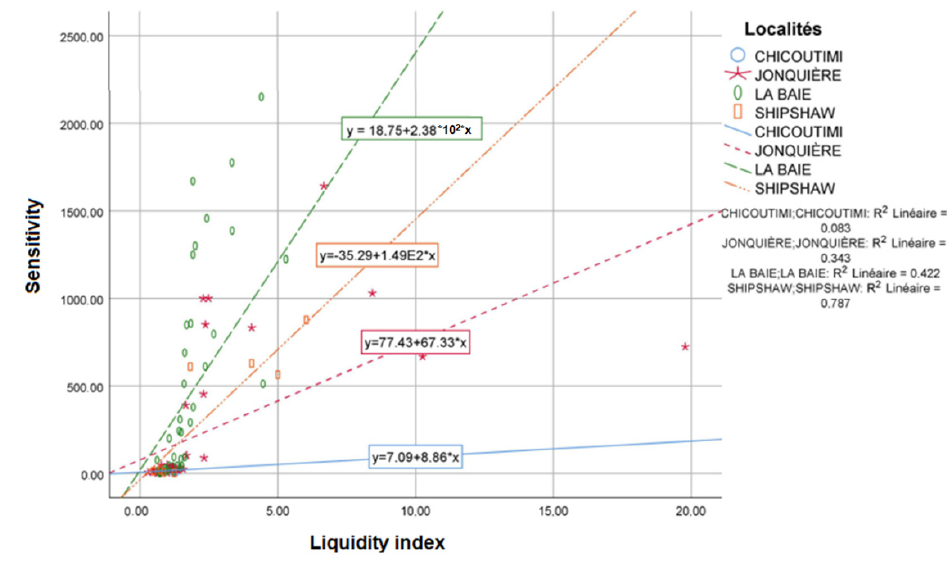
Figure 15. Linear relationship between liquidity index and sensitivity for SLSJ clay and silt samples.